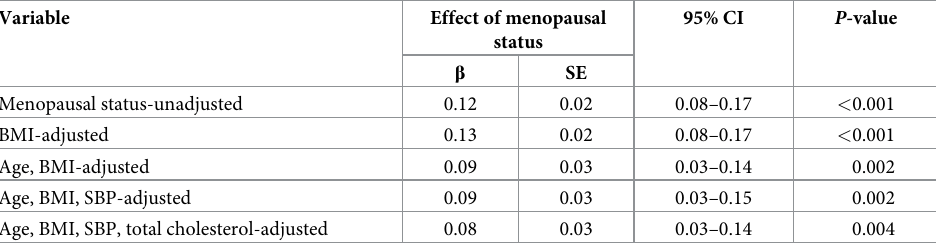
Table 5. Association of menopausal status with hemoglobin A1c by multiple linear regression analyses.